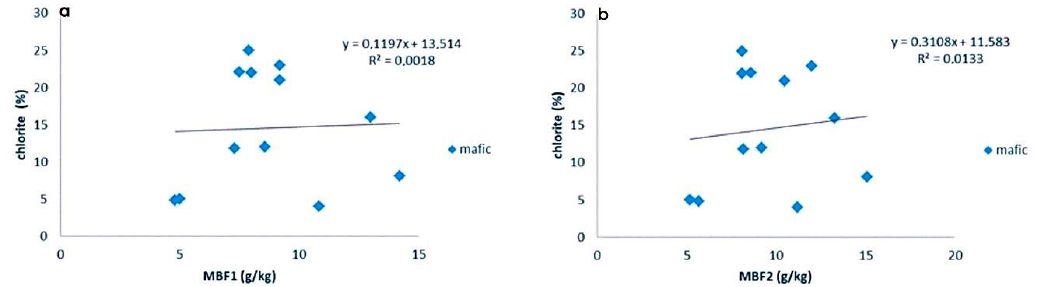
Figure 9. ( a ) Methylene blue test (MB F 1) plotted against the chlorite content of the mafic studied rocks, ( b ) modified methylene blue test (MB F 2) plotted against the chlorite content of the mafic studied rocks.